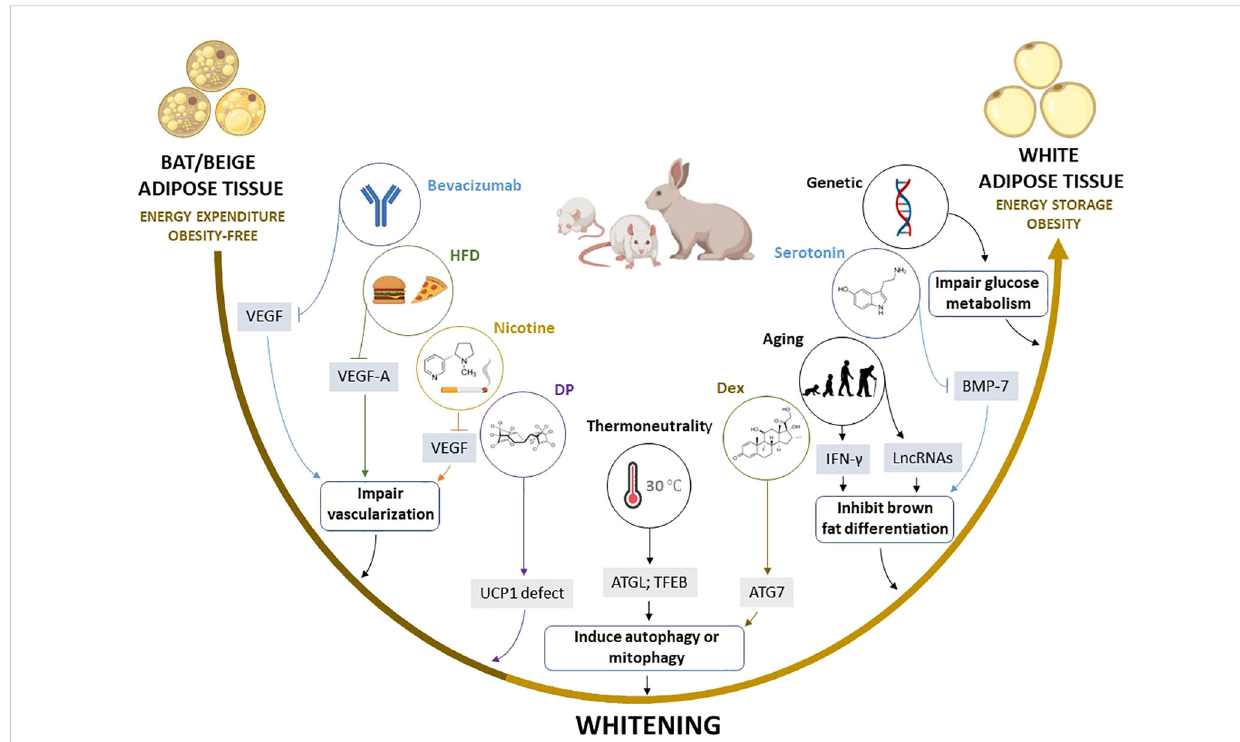
FIGURE 4 Summary of the proposed mechanisms by which multiple factors induce the whitening of brown (BAT) and beige adipose tissue. Factors such as high fat diet (HFD), bevacizumab, and nicotine induce the whitening by suppressing pro-angiogenic cytokines such as VEGF and VEGF-A, which inhibit angiogenesis and impair vascularization in BAT and beige adipose tissue, whereas thermoneutral zone and dexamethasone (Dex) exposure increase ATG7 and TFEB, which stimulate autophagy or mitophagy. Other factors such as aging, and elevated serotonin induce BAT/beige adipose tissue whitening by increasing INF- g , and LncRNAs, and decreasing BMP-7, which in turn inhibits brown adipocyte differentiation. Moreover, dechlorane plus (DP) contributes to whitening in part by inhibiting UCP1 expression. ATG7, autophagy-related 7; LncRNAs, long non-coding RNAs;